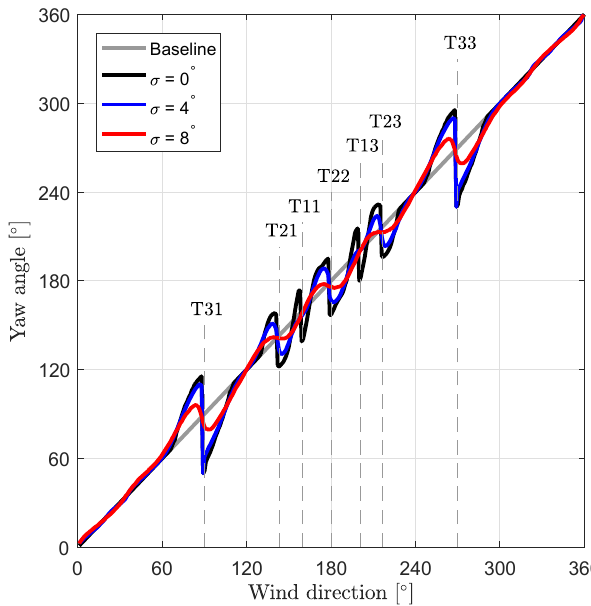
Figure 6. Optimized yaw angles of the centre turbine in the south- ernmost row (T32) for three different robustness parameters σ = 0, 4, and 8 ◦ . In addition, directions are marked and named accordingly, at which neighbouring turbines are located